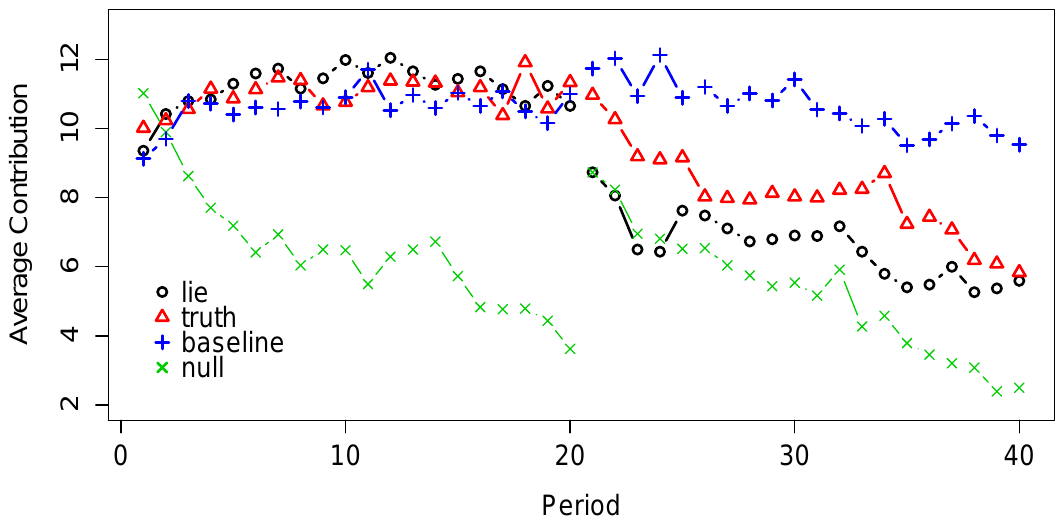
Figure 1. Average contributions by periods across